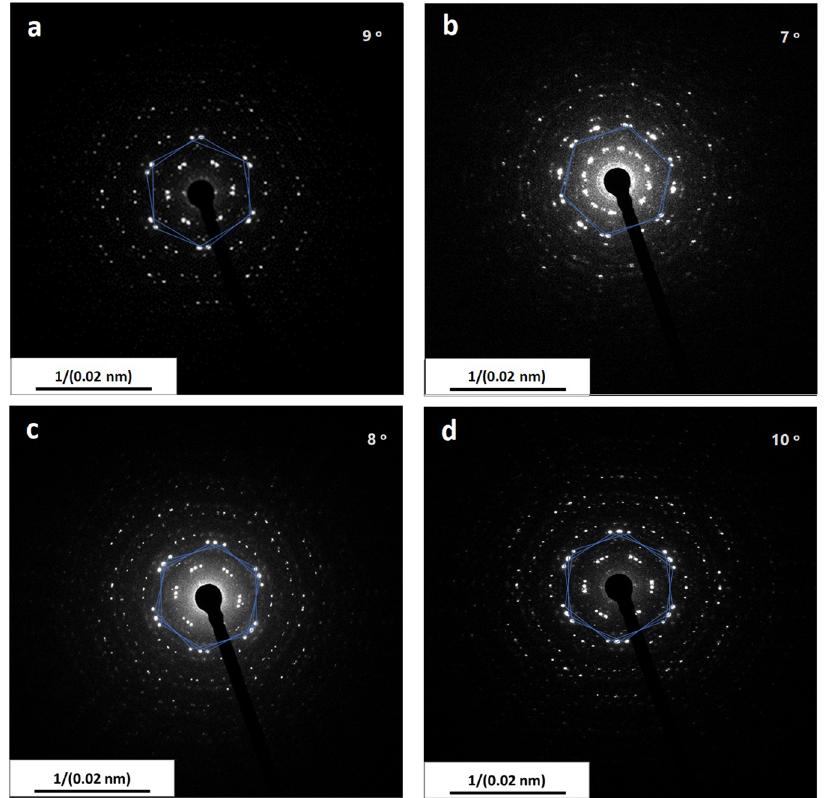
Fig. 4 The distribution of various twist angles of a few-layer TaS 2 . The SAED patterns taken from a large area refer to the various twist of the a, b bilayer and c, d three-layer TaS 2